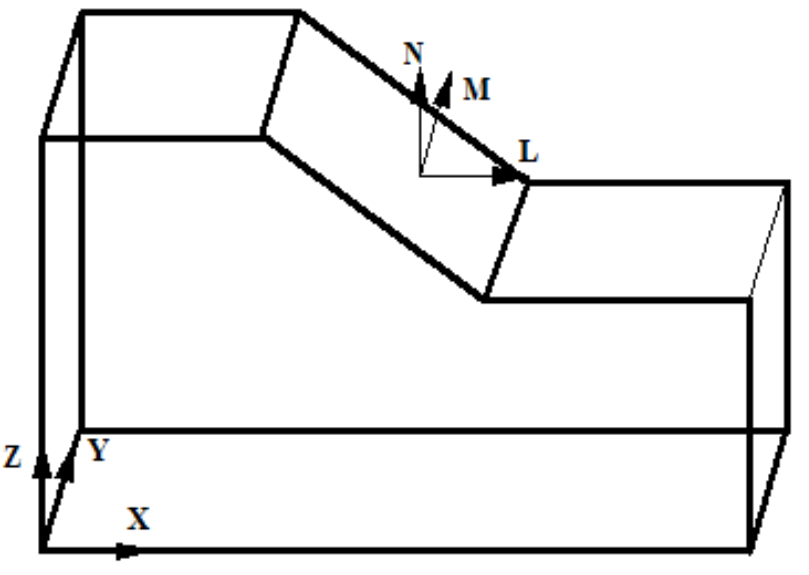
Figure 15. Coordinate system transformation.